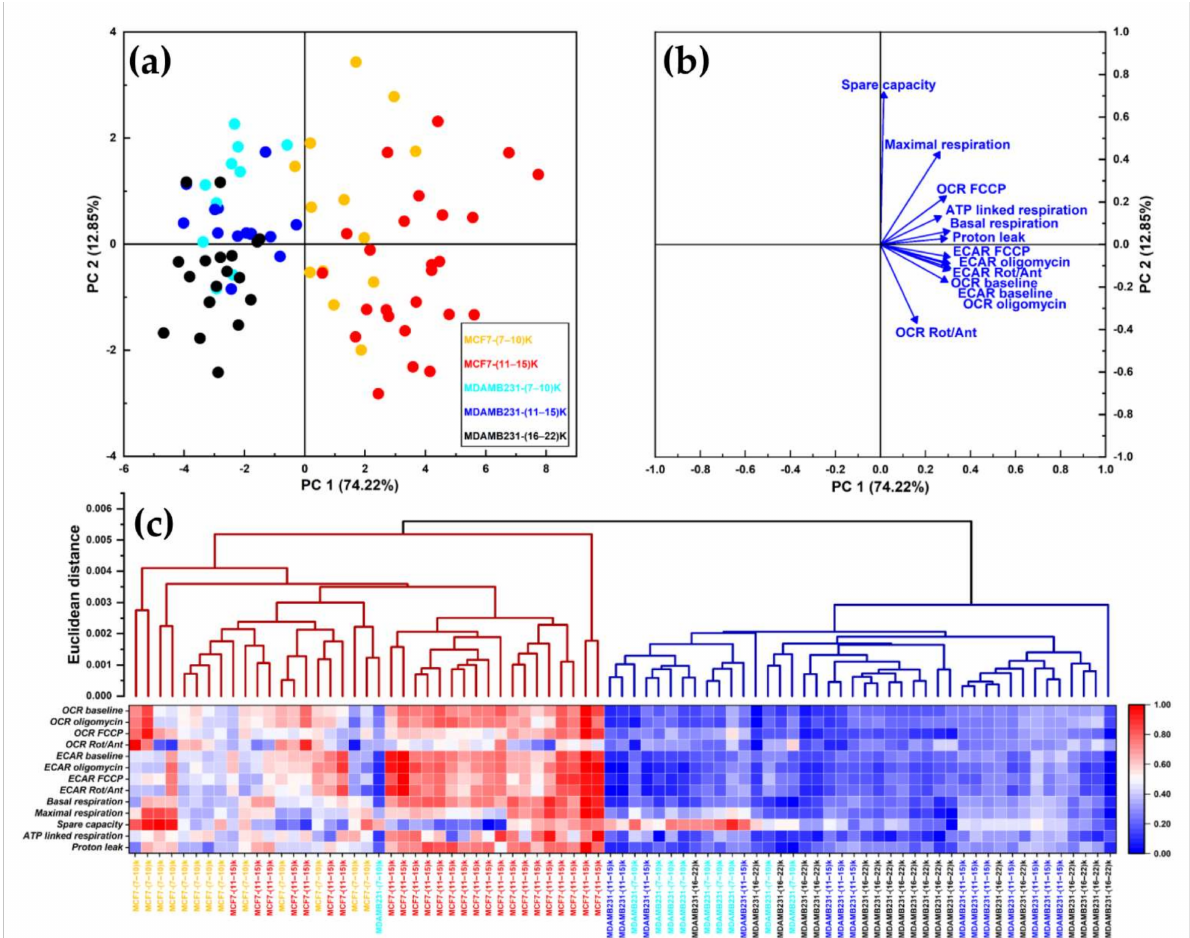
Figure 5. Multivariate statistical analysis for the metabolic parameters of MCF7 and MDA-MB-231 spheroids normalized on the number of cells in each spheroid. ( a ) Principal component analysis (PCA) scores plot. Data are projected onto the two-dimensional space defined by the Principal Component 1 (PC1) and Principal Component 2 (PC2), which together explain about 87% of total data variance. Each symbol represents a single spheroid, color-coded according to the cell line of origin and the cellular counts. ( b ) PCA Loading plot, showing the relationship between the original variables and the Principal Components. ( c ) Hierarchical clustering. The two clusters identified (dark red and dark blue branches) neatly separate spheroids from the two cell lines. The heatmap displays the values of metabolic parameters for each spheroid, scaled to the [0–1] range and color-coded